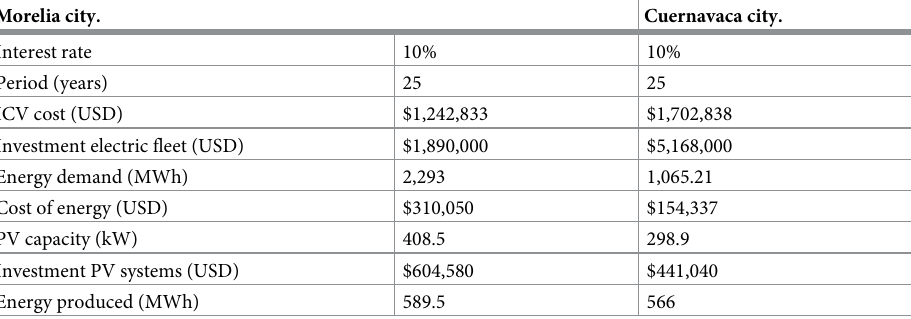
Table 10. Considerations in economic evaluation.